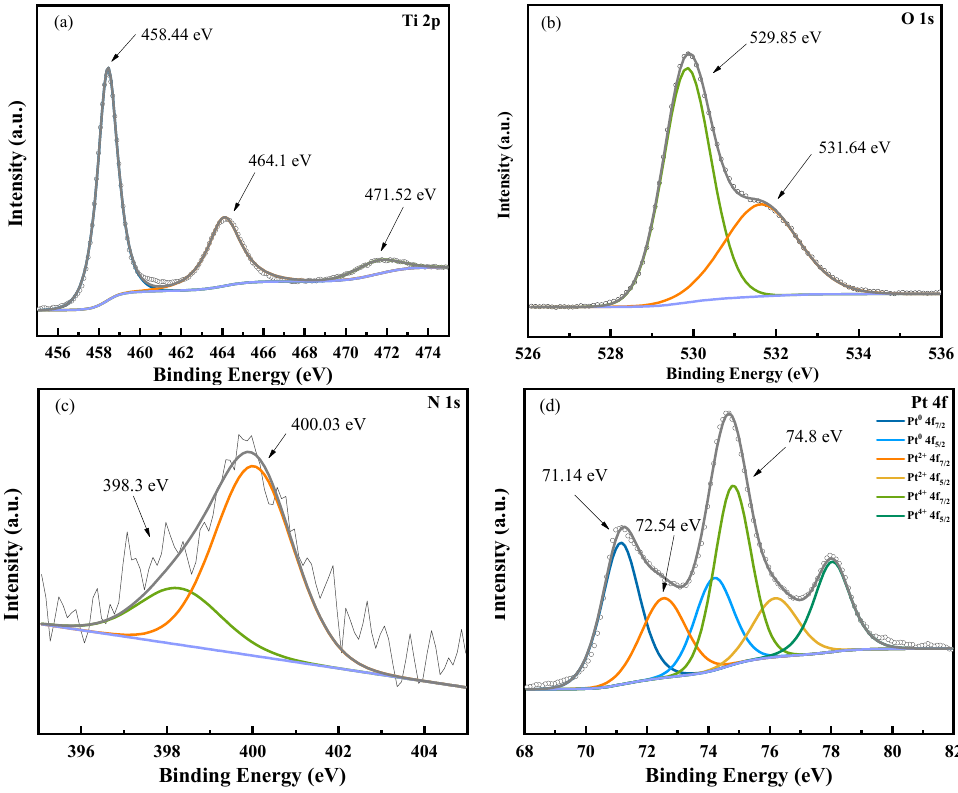
Figure 2. XPS pattern of Pt ‐ N ‐ TiO 2 nanotube electrode: ( a ) Ti 2p; ( b ) O 1s; ( c ) N 1s; ( d ) Pt 4f.